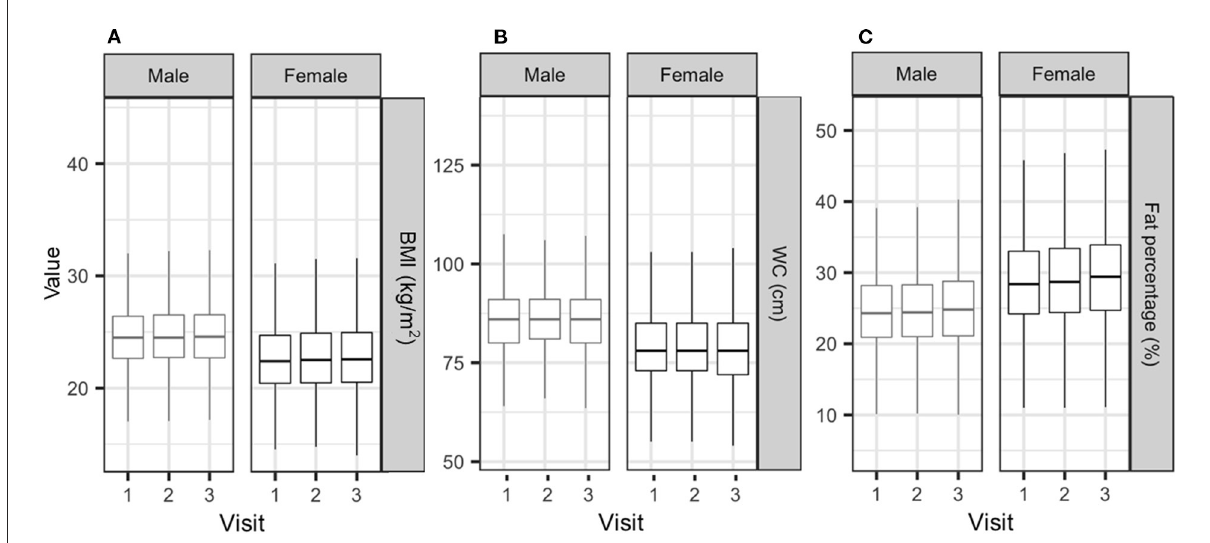
FIGURE2 Distribution of BMI (A) , waist circumference (B) , and body fat percentage (C) according to sex. BMI, body mass index; WC, waist